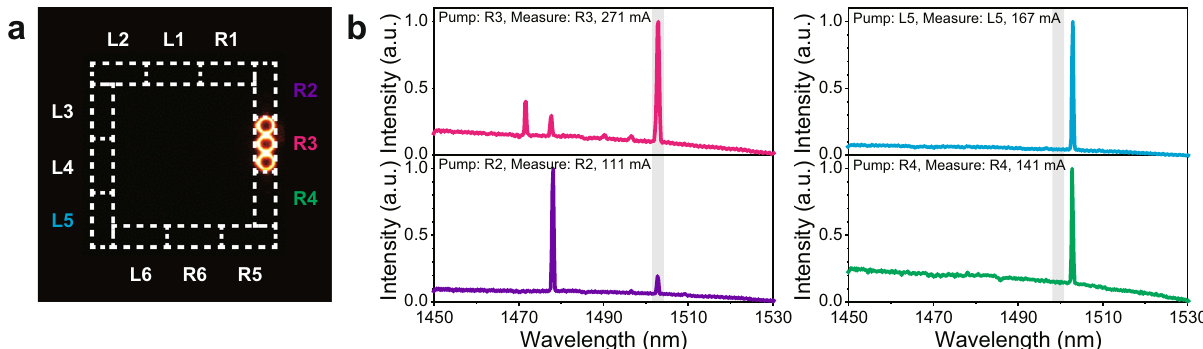
Fig. 4 Topological edge mode vs. locally excited modes. a Pro fi le intensity image when the current is injected into only one of the twelve electrodes (in this case R3). b Measured electroluminescent spectra when the current is injected into different electrodes. The topological edge mode at a wavelength of 1503 nm persists in all cases (gray shaded area) while in some cases localized modes are excited that prevail